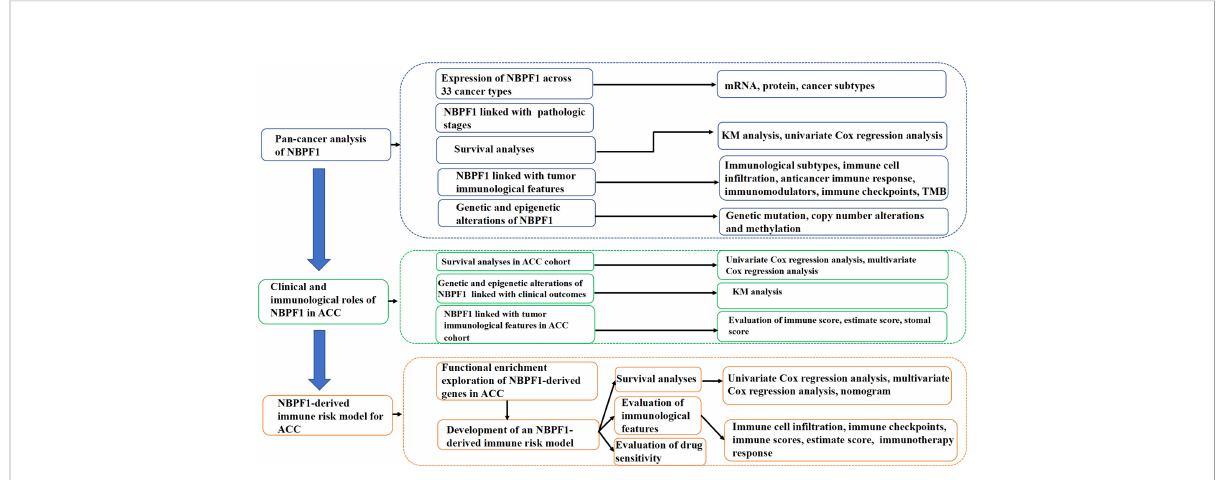
FIGURE 1 The analysis and indicators involved in the